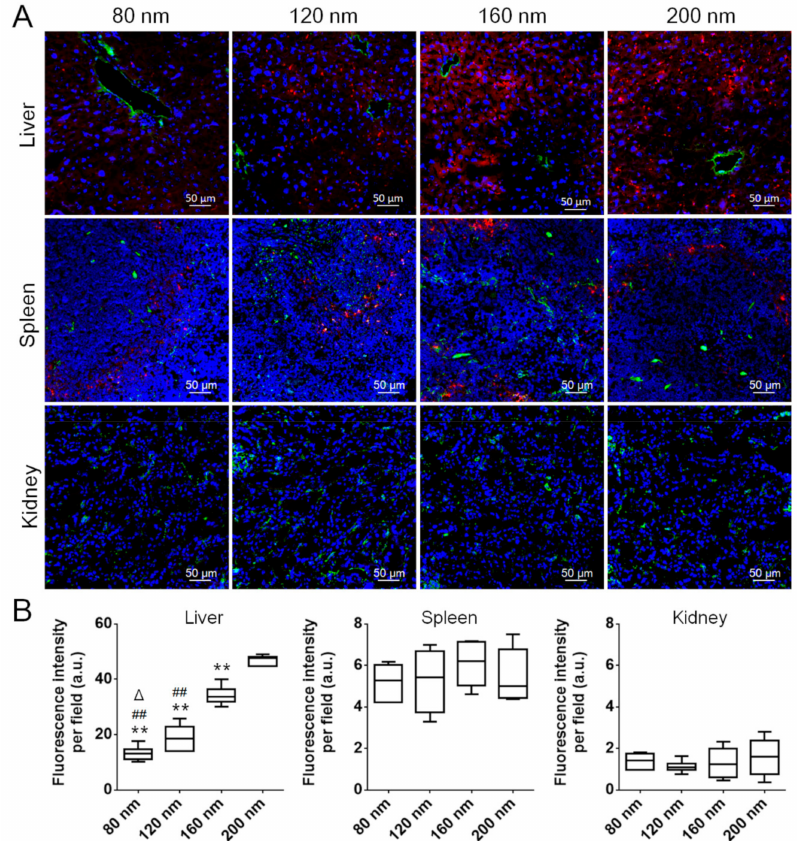
Figure 6. RBC-NP distribution in organ slices 48 h post intravenous injection. ( A ) Confocal microscopy images of four di ff erent-sized RBC-NPs in liver, spleen and kidney slices. Red represents RBC-NPs. Blue represents cell nuclei. Green represents blood vessels. ( B ) Fluorescence intensity of four di ff erent-sized RBC-NPs in liver, spleen, and kidney slices. ** p < 0.01 compared with 200 nm. ## p < 0.01 compared with 160 nm. ∆ p < 0.01 compared with 120